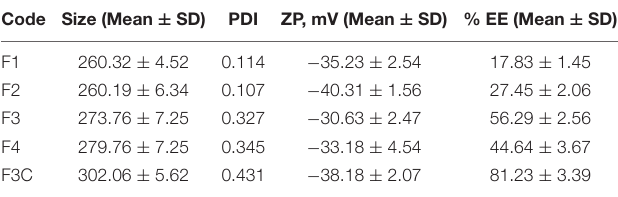
TABLE 1 | Particle characterization of developed